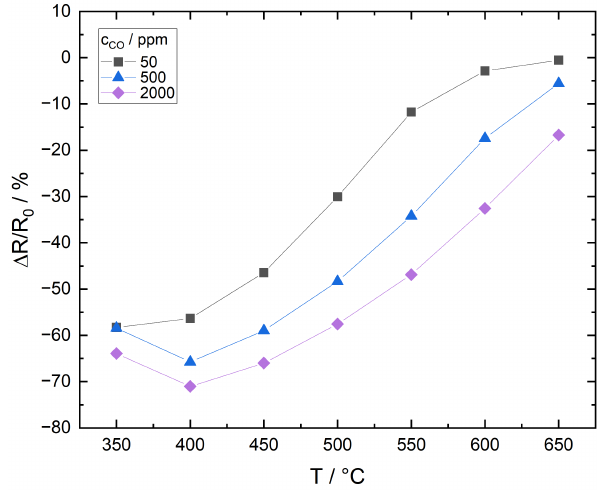
Figure 16. Relative resistance change of ITO thick film as a function of temperature for 3 different CO concentrations, measured in N 2 /O 2